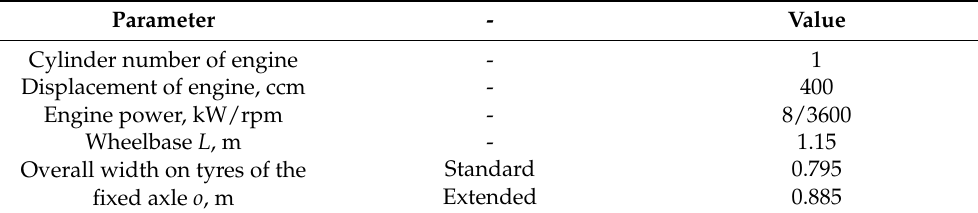
Table 1. Specifications of the experimental tractor Mini 070.